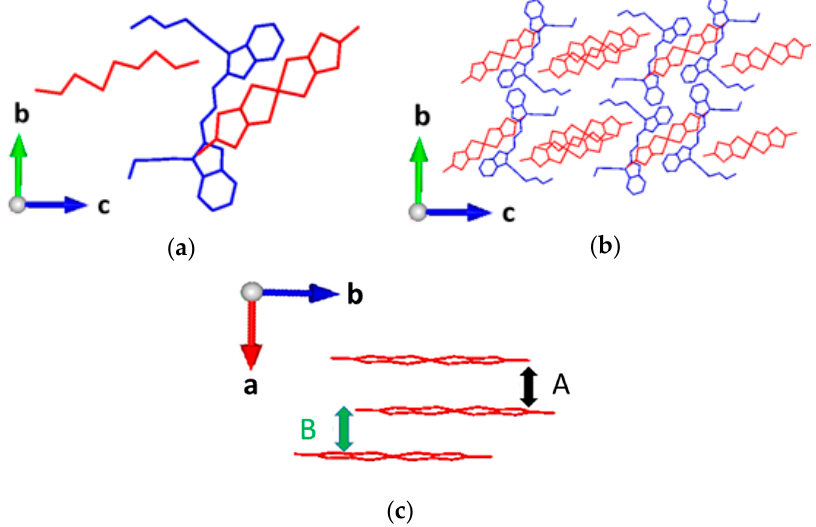
Figure 3. Crystal structure of DiCC 2 [Ni(dmit) 2 ] 3 . Red; Ni(dmit) 2 anon, blue; DiCC cation, hydrogen atoms are omitted for clarity: ( a ) asymmetric unit containing one and a half of the anions and a whole cation; ( b ) view down along a ‐ axis; ( c ) interaction between anions in stacking columns along the a ‐ axis. In ( c ), the shortest sulfur–sulfur distances between the two anions designated as A and B are 3.792(3) and 3.688(3) Å, respectively.